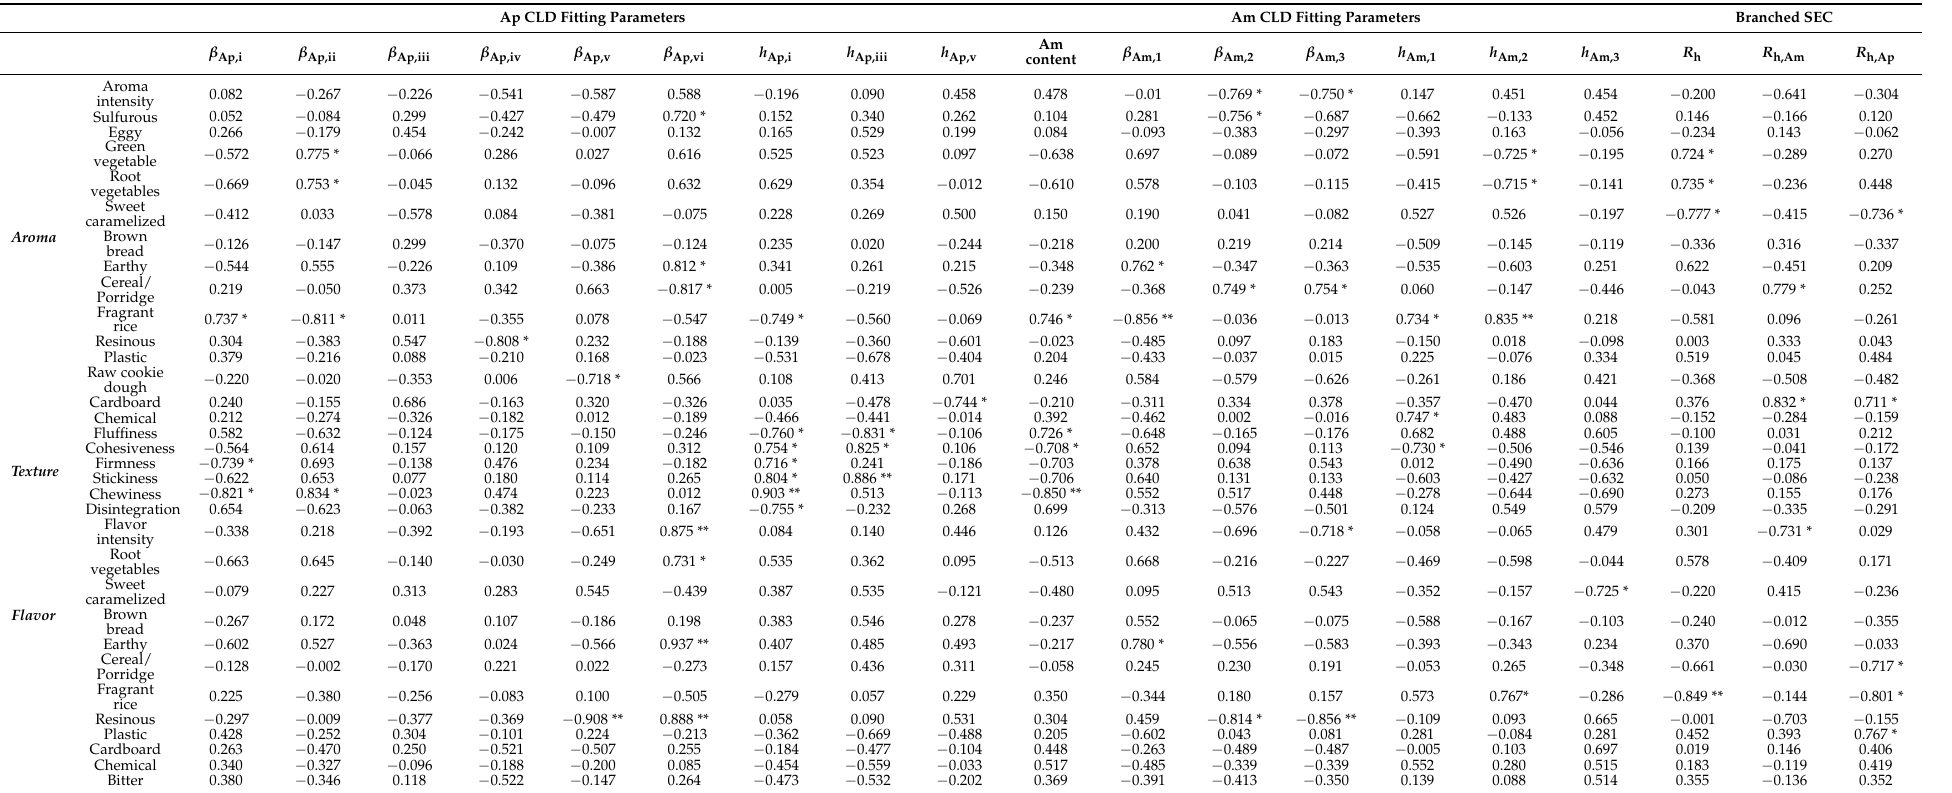
Table 5. Pearson correlation between rice sensory measured by panelists and starch structural parameters ( n = 8) 1 . ApCLDFittingParameters